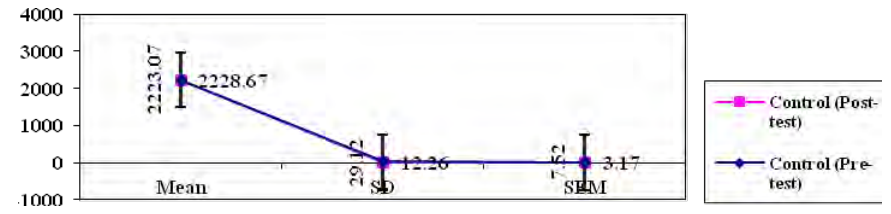
Fig. 10. Descriptive Statistics of Inspiratory Reserve Volume (IRV) of (a) Experimental (Pre & Post) and (b) Control (Pre & Post) group of University Level Girls